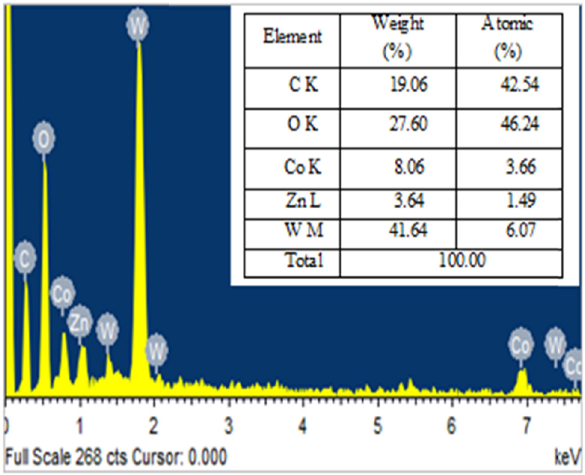
Figure 1: EDX coating of electrode.